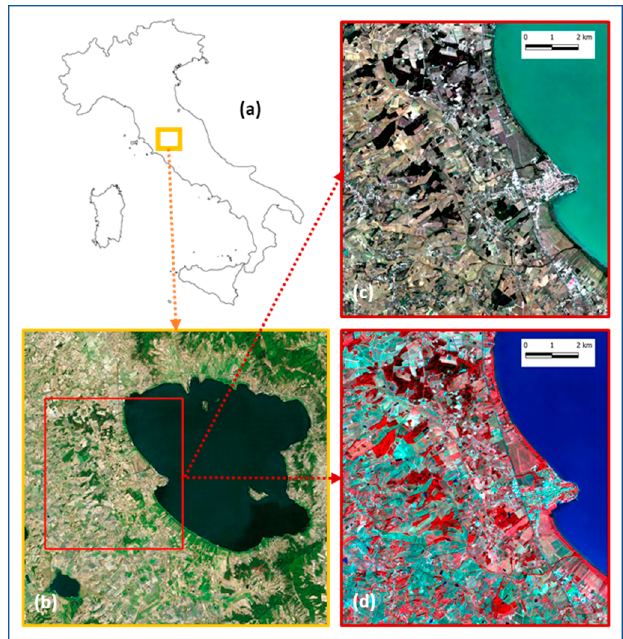
Figure 1. Study area location in Umbria, Italy ( a ) and overview of the Trasimeno Lake area ( b ). RGB image ( c ) and composite infrared image ( d ) based on 10 m resolution Sentinel 2 bands.